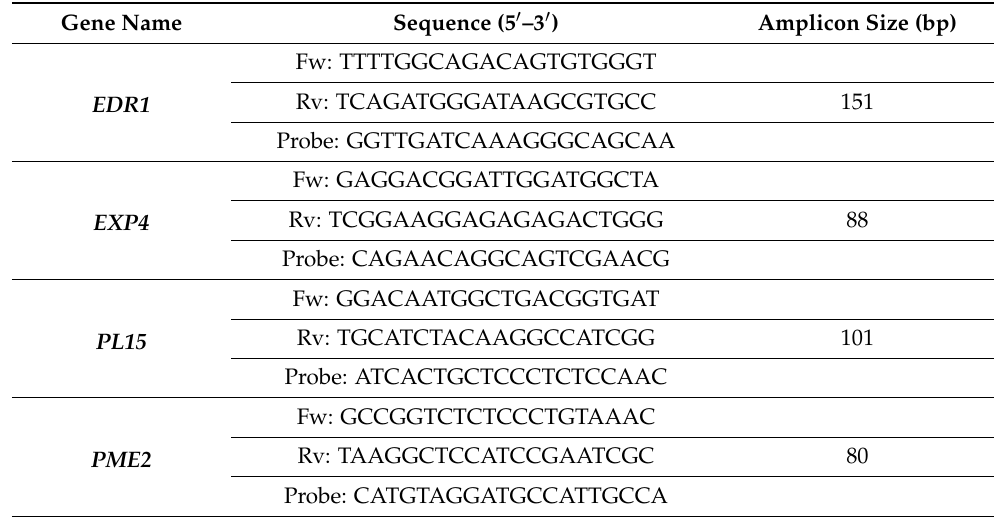
Table 3. Primer’s sequence used to amplify the genes of this study. Fw and Rv mean forward and reverse primers,